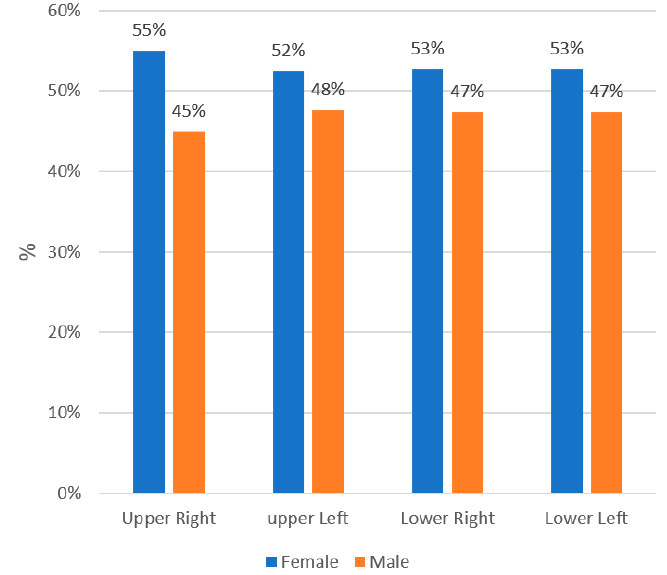
Figure 2. The effect of gender on the prevalence of taurodont molars.